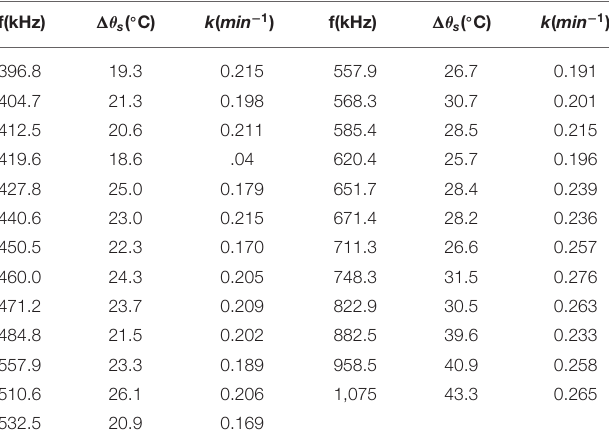
FIGURE 4 | Changes in the sample temperatu vs. time with respect to the initial temperature at t = 0 min .